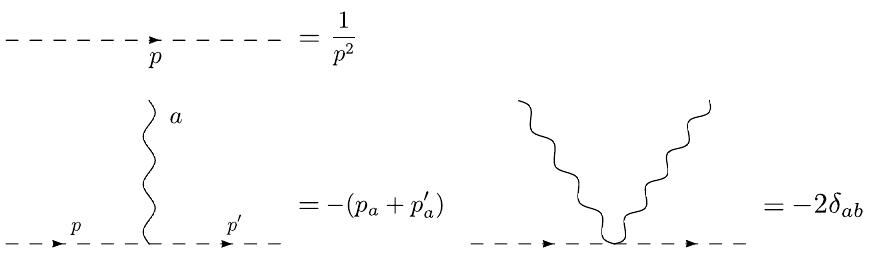
Figure 13 . Feynman rules with the complex scalar on the